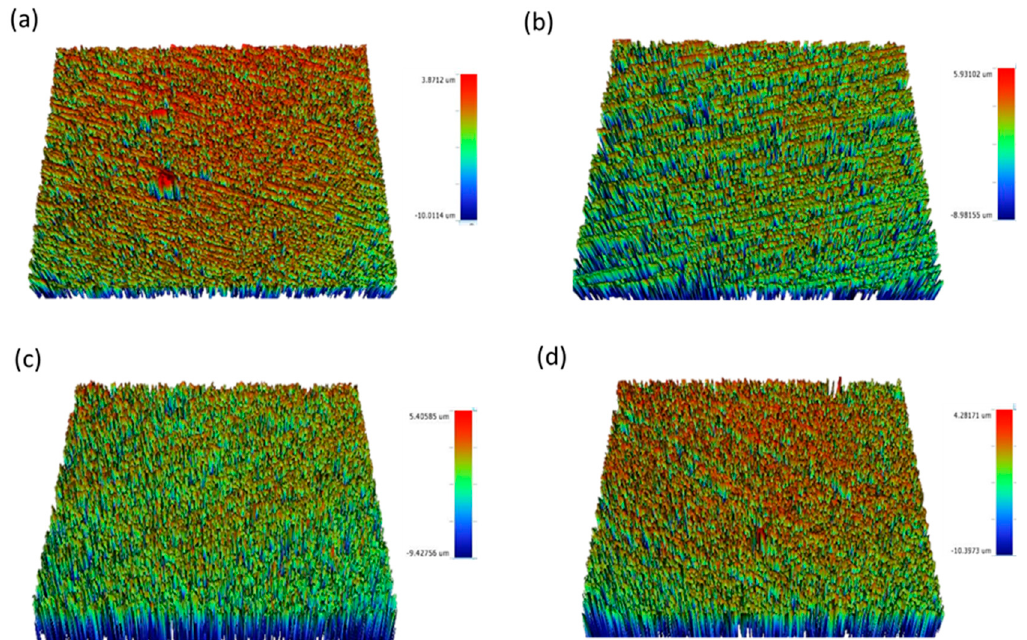
Figure 3. Surface roughness (Ra) of control group of each: ( a ) CD, ( b ) CT, ( c ) IPE, and ( d ) IPS. CD; zirconia-reinforced lithium silicate (Celtra Duo). CT; advanced lithium disilicate (CEREC Tessera). IPE; lithium disilicate (IPS Emax CAD). IPS; leucite-reinforced (IPS Empress CAD).